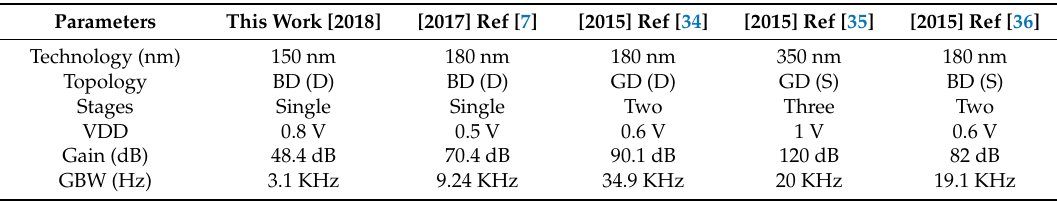
Table 4. Comparison of the different parameters of the OTA in the current study with different OTAs available in the literature.